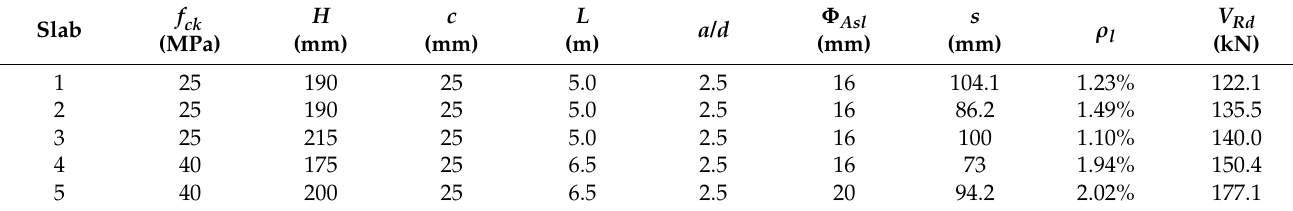
Table 3. Cases of design for shear design of NAC slabs without shear reinforcement using EN1992 [31].